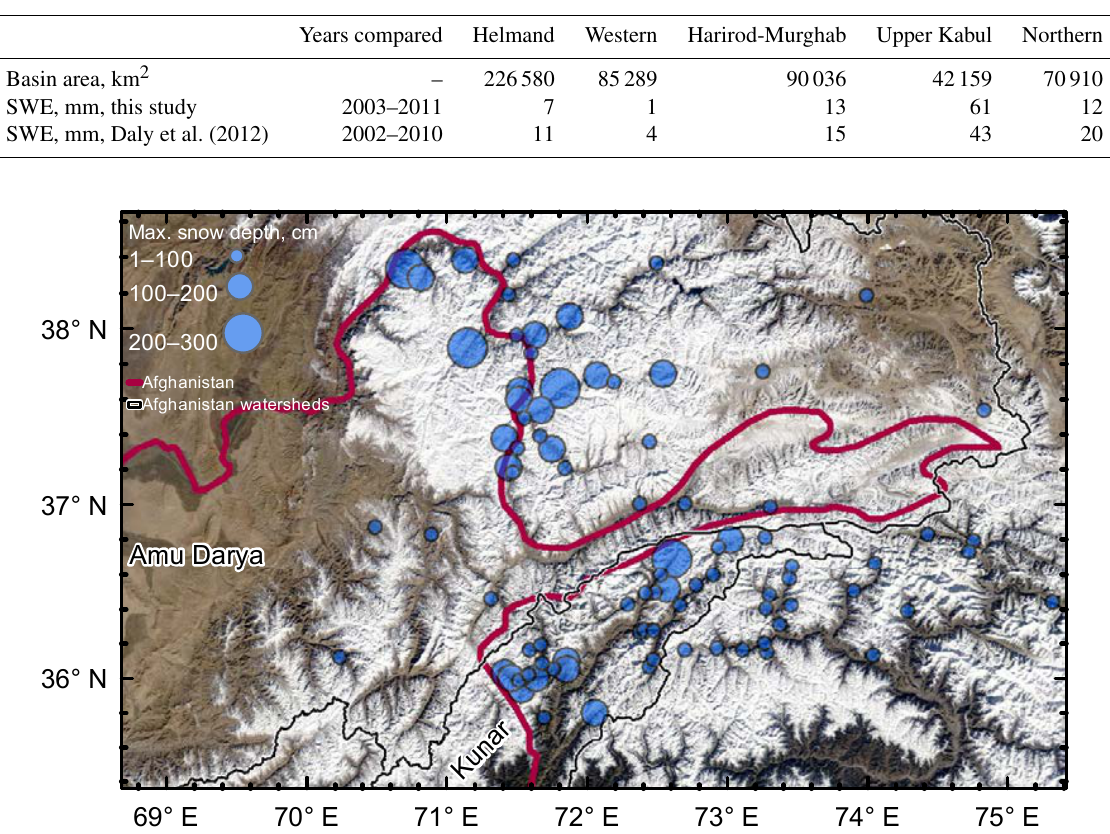
Table 3. Basin area and 1 April reconstructed mean basin-wide SWE estimates from this study compared to passive microwave (AMSR-E) estimates from Daly et al. (2012). Highly glacierized basins are excluded.